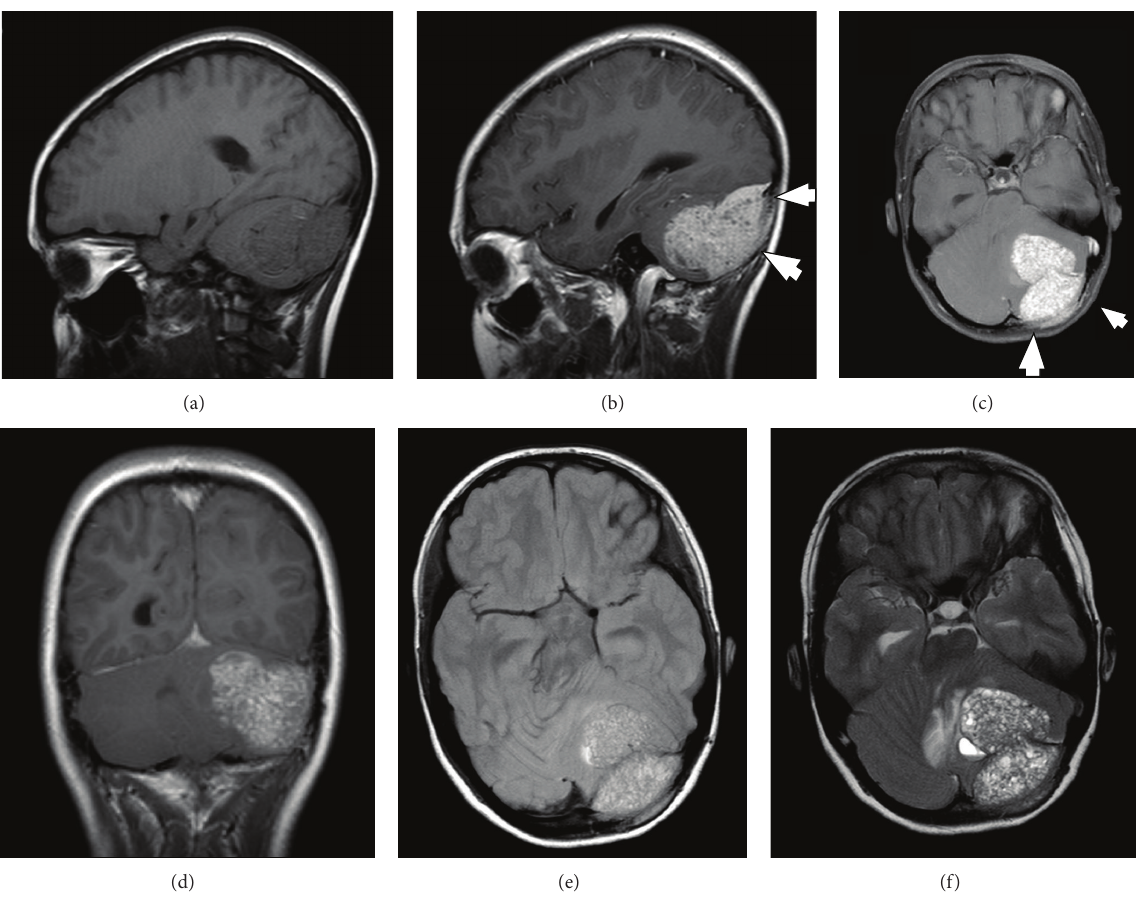
Figure 1: Preoperative MRI demonstrates a large contrast-enhancing dural-based tumor extending into the left posterior fossa forming two bulks. (a) T1-weighted noncontrast sagittal MRI. (b) T1-weighted contrast-enhanced sagittal view: short arrows indicate bone erosion. (c) T1-weighted contrast-enhanced axial MRI: short arrows indicate bone erosion. (d) T1-weighted contrast-enhanced coronary MRI. (e) Fluid attenuated inversion recovery- (FLAIR-) weighted coronal MRI. (f) T2-weighted axial